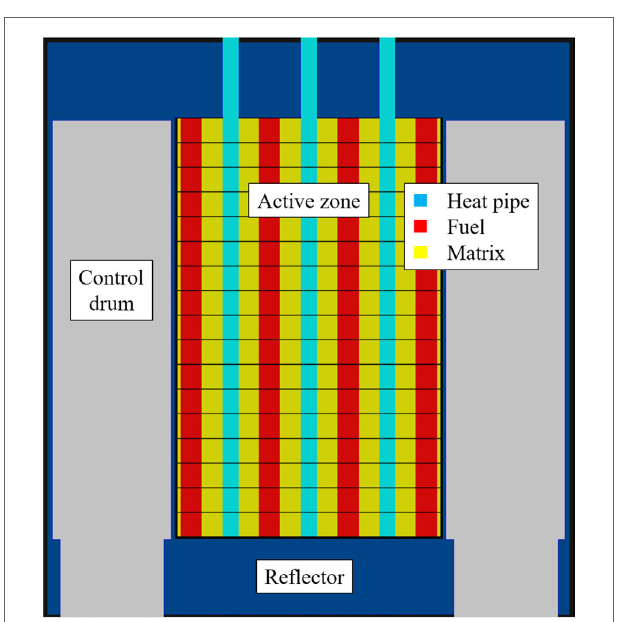
FigUre 4 | Calculation model of reactor core.